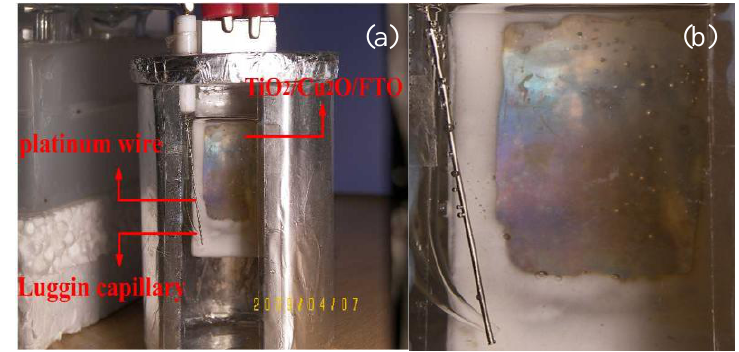
Figure 15. Photograph of three electrode system in photoelectrochemical experiment with persistent visible irradiation for 6 h with (a) low magnification and (b) high magnification